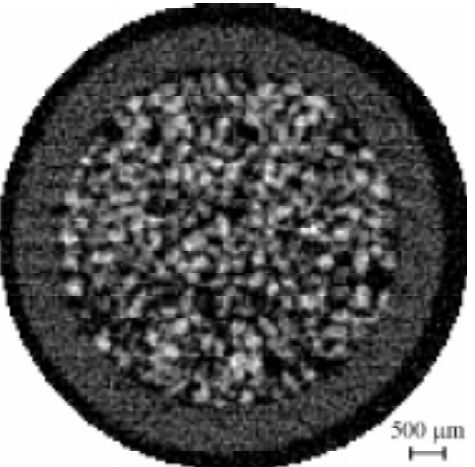
Figura 3. Tomografia de amostra deformada de Podzólico Vermelho, apresentando agregados de 212 a 250 mmmmm m. As regiões mais escuras representam o ar.